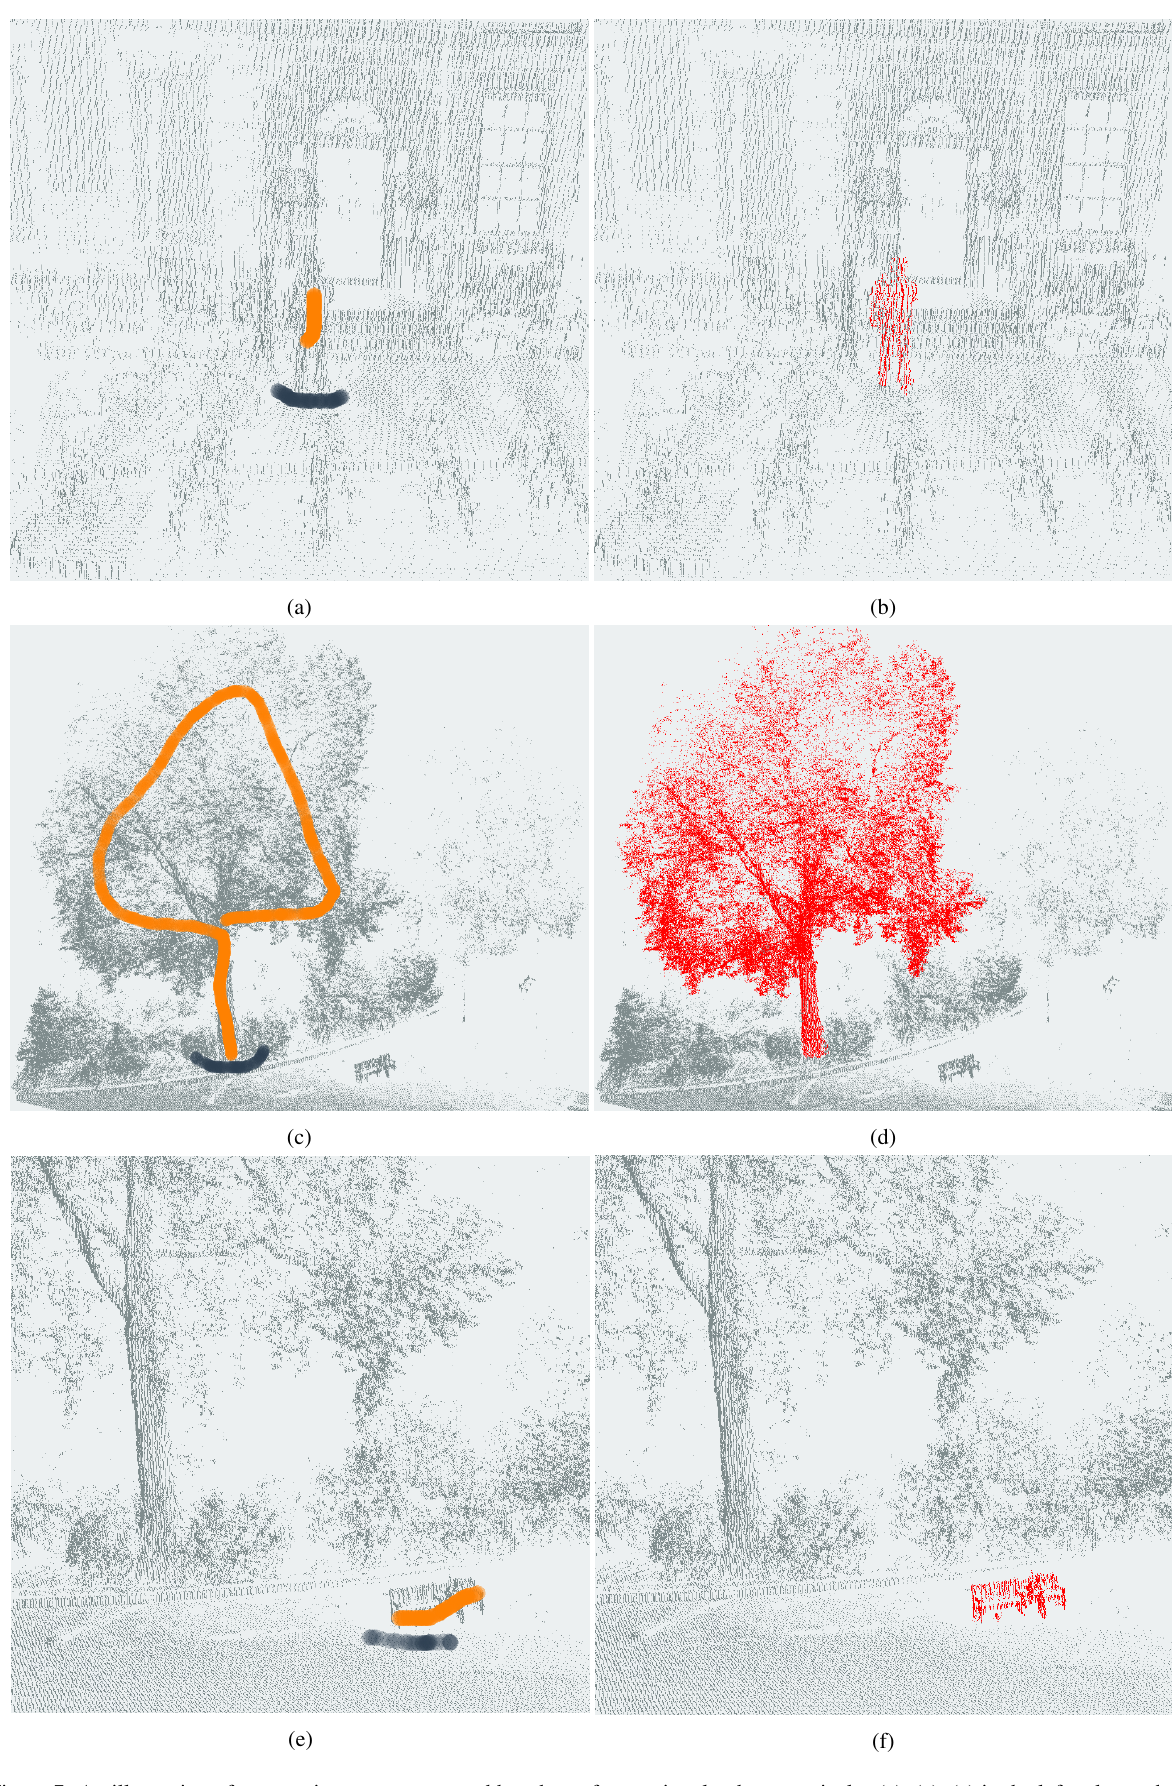
Figure 7: An illustration of segmenting person, tree and bench out from point clouds respectively: (a), (c), (e) in the left column show the user interactions and (b), (d), (f) in the right column display the corresponding